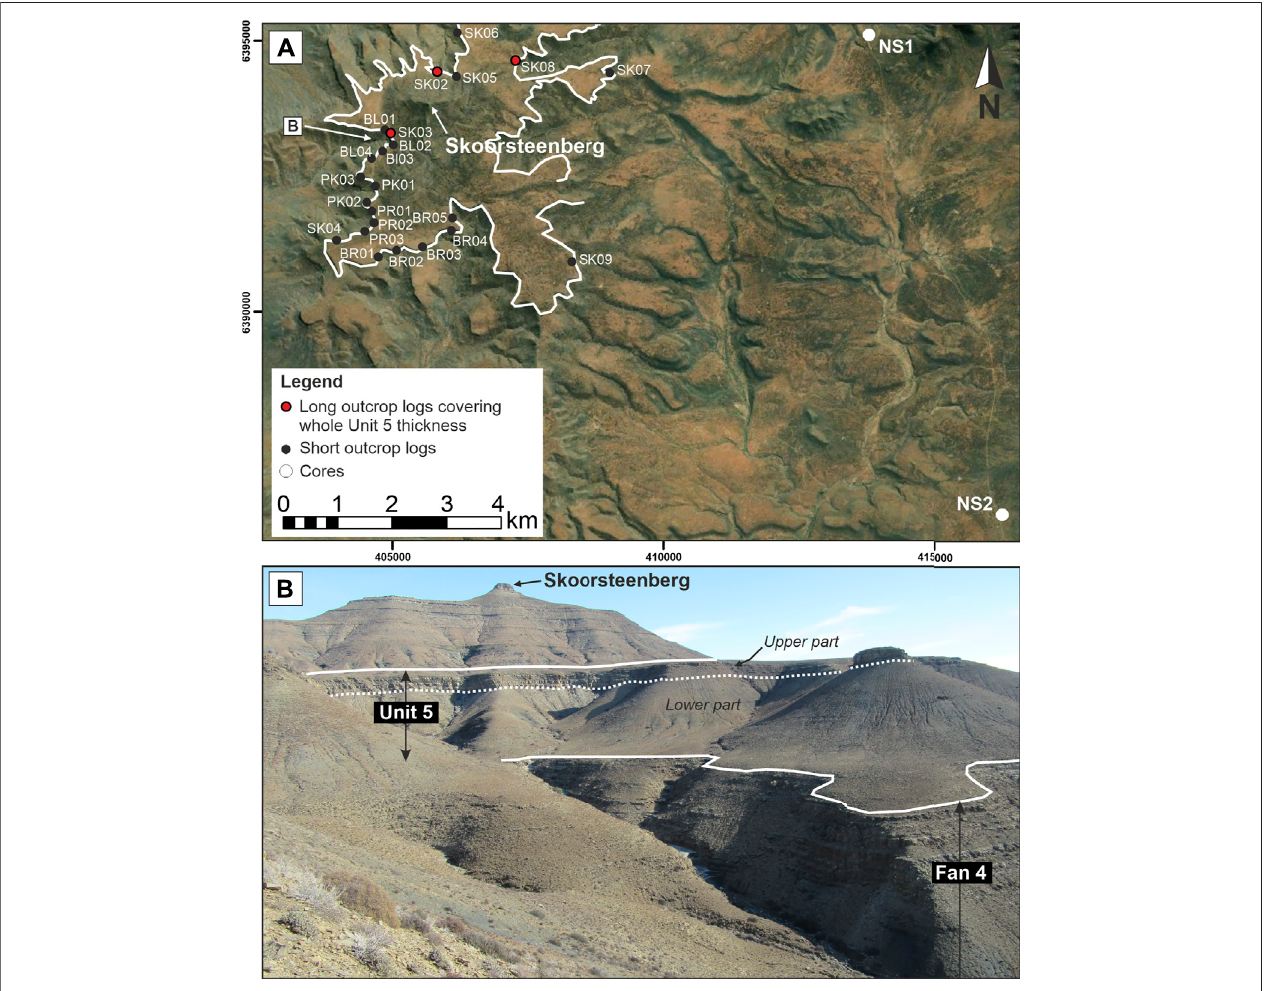
FIGURE 2 | (A) Adetailedmapofthestudyareawithloglocationsinindicated. (B) OverviewphotoofthestudyareashowingFan4andthepartitioningseeninUnit5.